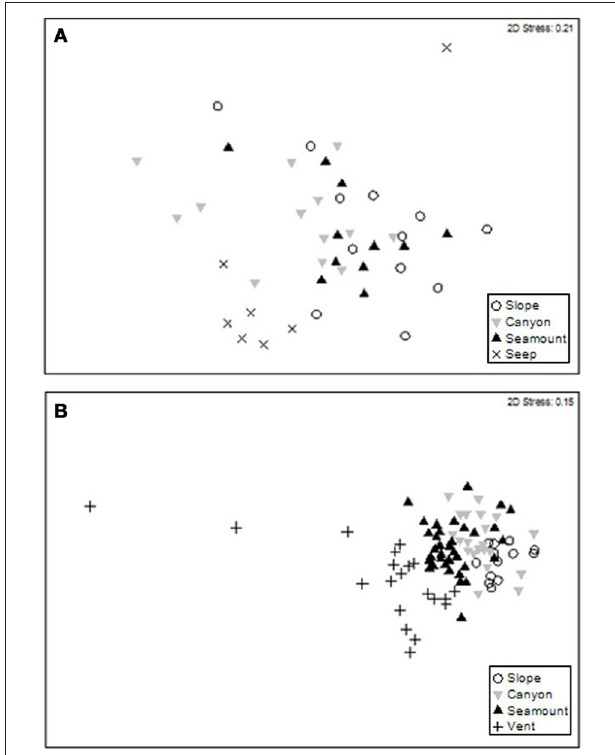
FIGURE 4 | MDS ordination plots showing megafaunal community similarity among samples at habitats on (A) the Hikurangi Margin, and in (B) the Bay of Plenty.